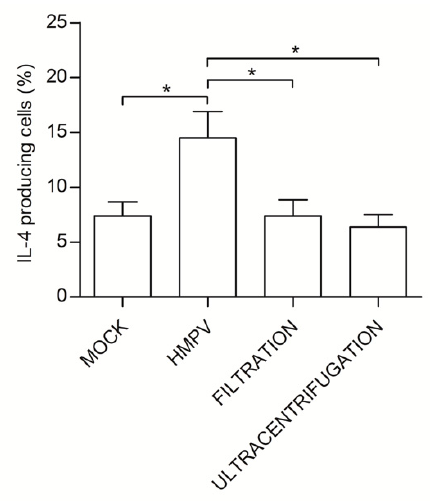
Figure 5. Virus clearance from HMPV-infected secretome abolishes the pro-Th2 effects. The DCs were treated for 48 h with mock secretome, HMPV-infected secretome or with secretomes derived from HMPV-infected L-HMVECs where the virus was cleared by size exclusion (filtration) or ultracentrifugation. DCs were then co-incubated with allogenic naïve CD4 T cells for seven days. Bars represent the mean ± SEM of IL-4-producing cells (%) detected upon the described culture conditions. The results are from four independent experiments. * p < 0.05.